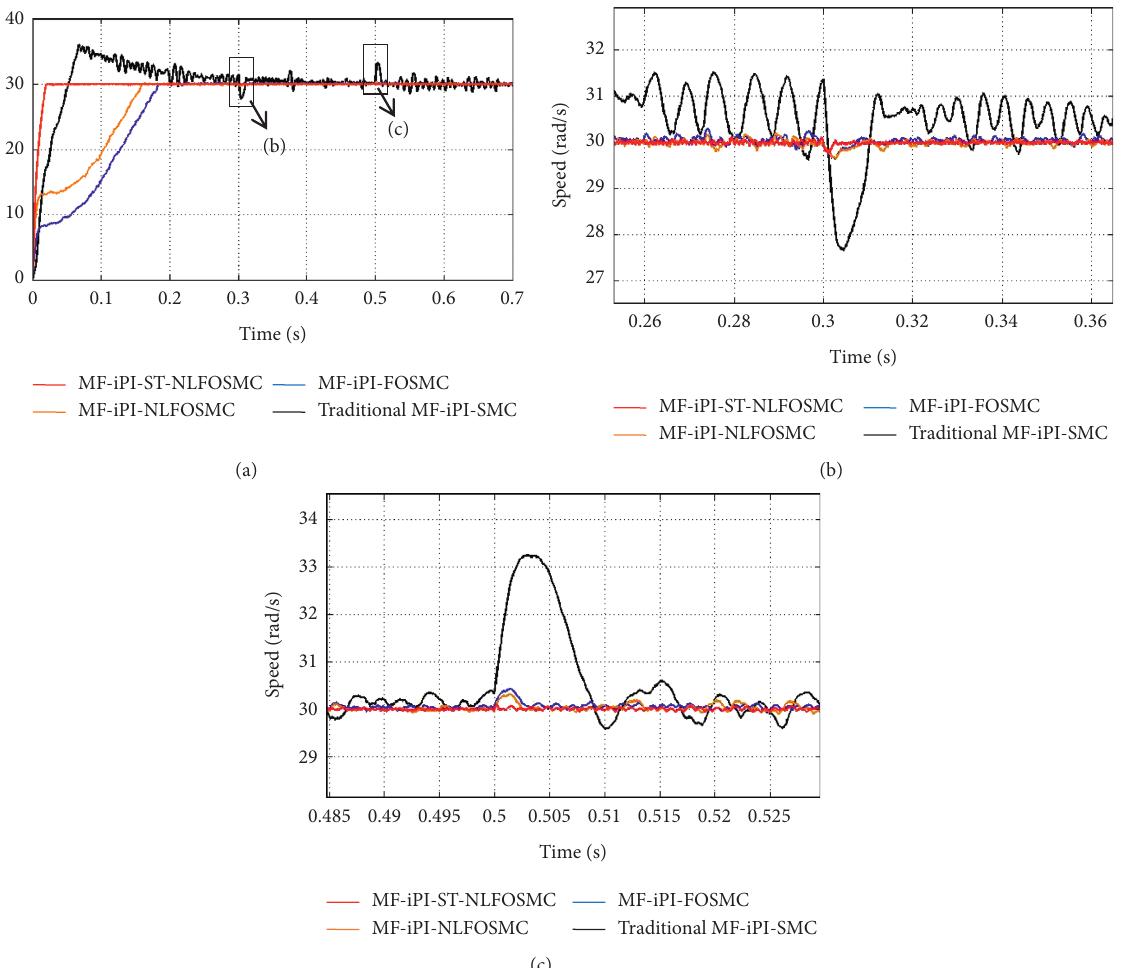
Figure 8: (a) Speed response curves when the external load changes suddenly. (b) Partial enlarged views of speed response curves when the external load becomes 0.7 N × m from 0 N × m at 0.3 s. (c) Partial enlarged views of speed response curves when the external load becomes 0 N × m from 0.7 N × m at